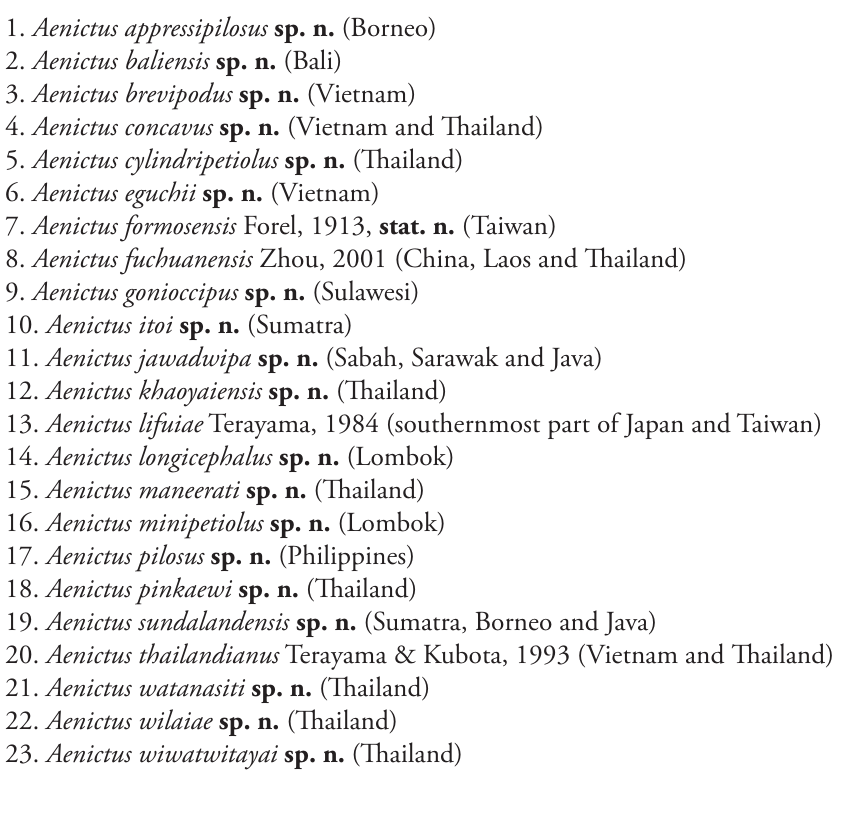
Key to Southeast Asian species based on the worker caste ble with more than 4 teeth/denticles) (Figs 11C, 17B) ................................